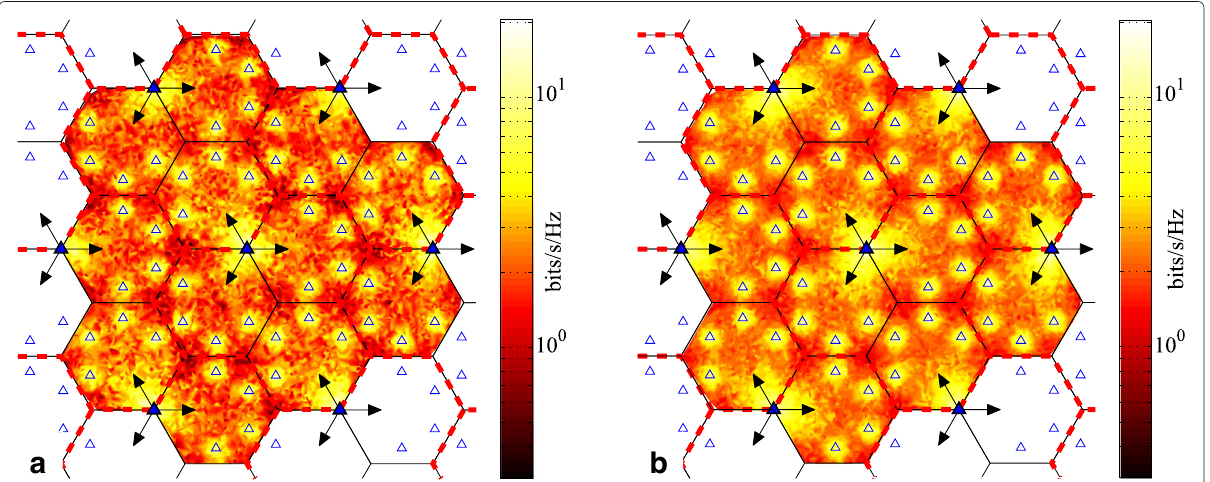
Fig. 11 Average achievable rate per user based on user position within cellular network, with PF scheduling for three-cell layout, using simulated annealing scheduling and SZF-DPC precoding; N macro = N pico = 2, M = 2, K c = 12. a Fixed clustering. b Rotating clustering ( T cl =